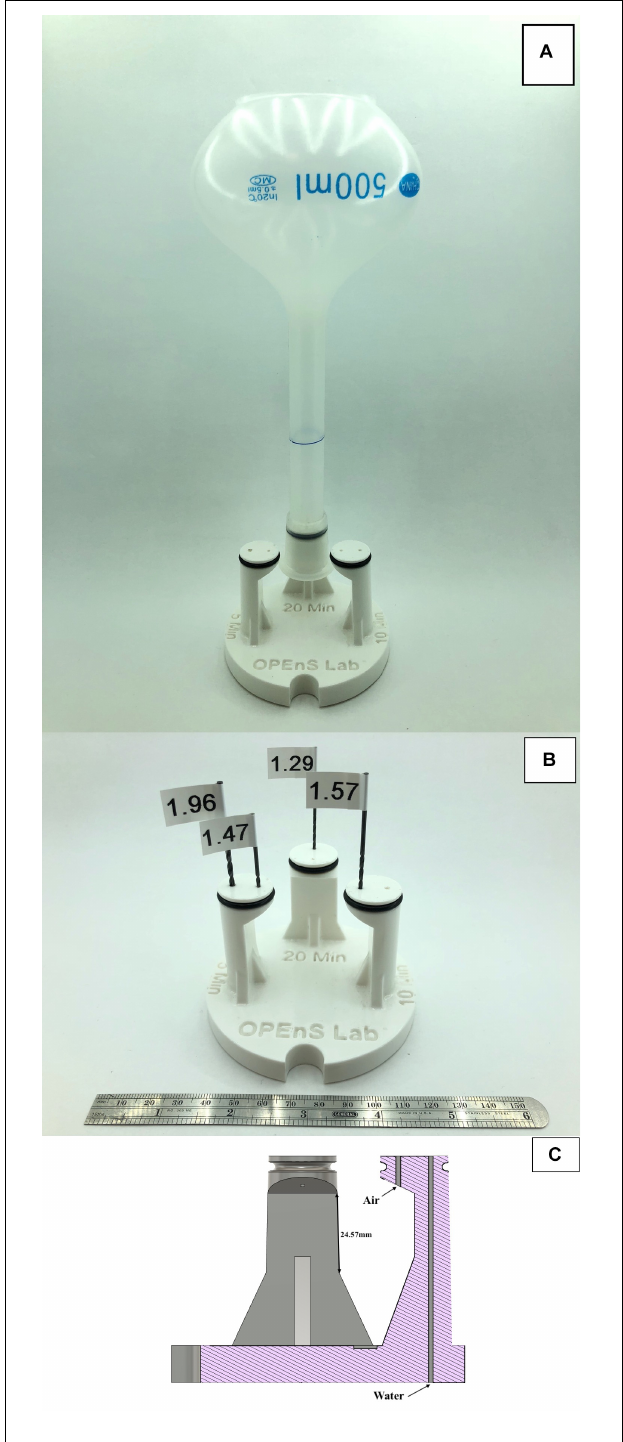
FIGURE 1 | (A) Assembled three-rate assembly system; the circular cutout in this version accommodates the solar radiation sensor located within the rain gauge for which this was designed. (B) A particular print of the design illustrates the limitations of many printers to achieve a smooth surface and presents the drill-bits sizes, in mm, employed to obtain reproducible performance. (C) CAD rendering of the design illustrates that each stopper has an air inlet port and water outlet